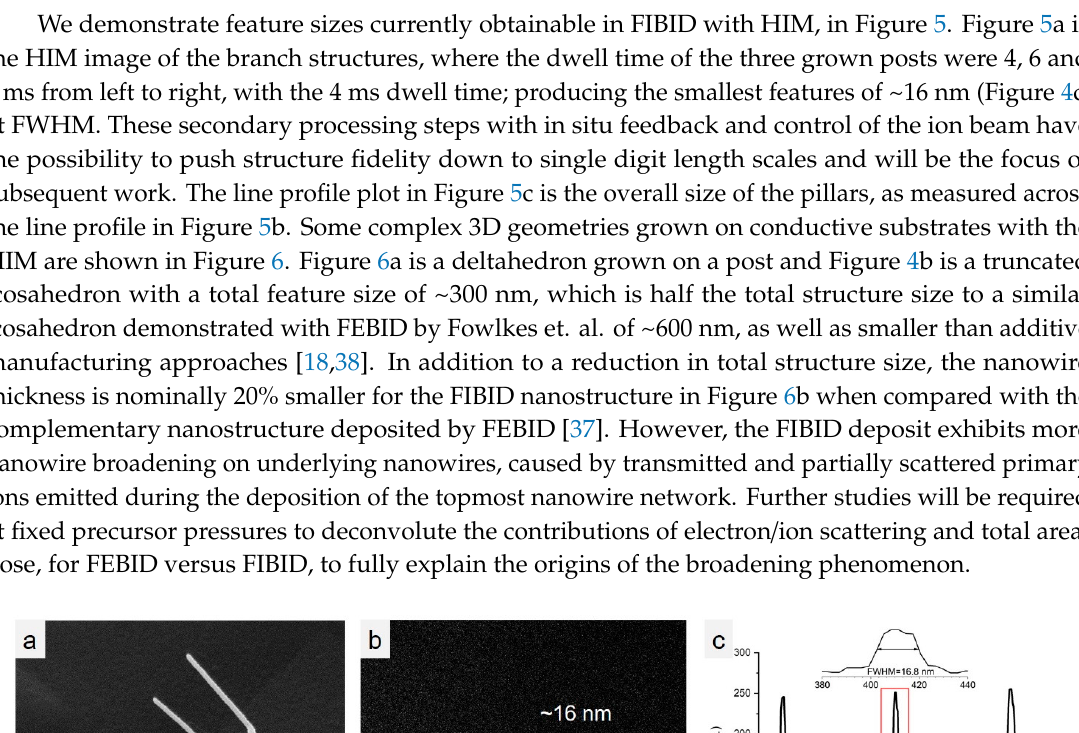
Figure 6. Complex 3D structures made with FIBID, ( a ) deltahedron grown on a pillar on a conductive substrate and ( b ) a truncated icosahedron a conductive substrate ( c ) pillars and ( d ) deltahedron grown on insulating SiO 2 . Furthermore, Figure 6c,d show pillars and a deltahedron grown on SiO 2 . To estimate the composition of the as-grown FIBID 3D nanostructures, energy dispersive x-ray analysis was used to characterize a 3D “sheet”. Qualitative EDS was used to determine the uncorrected C/Pt peak ratio for